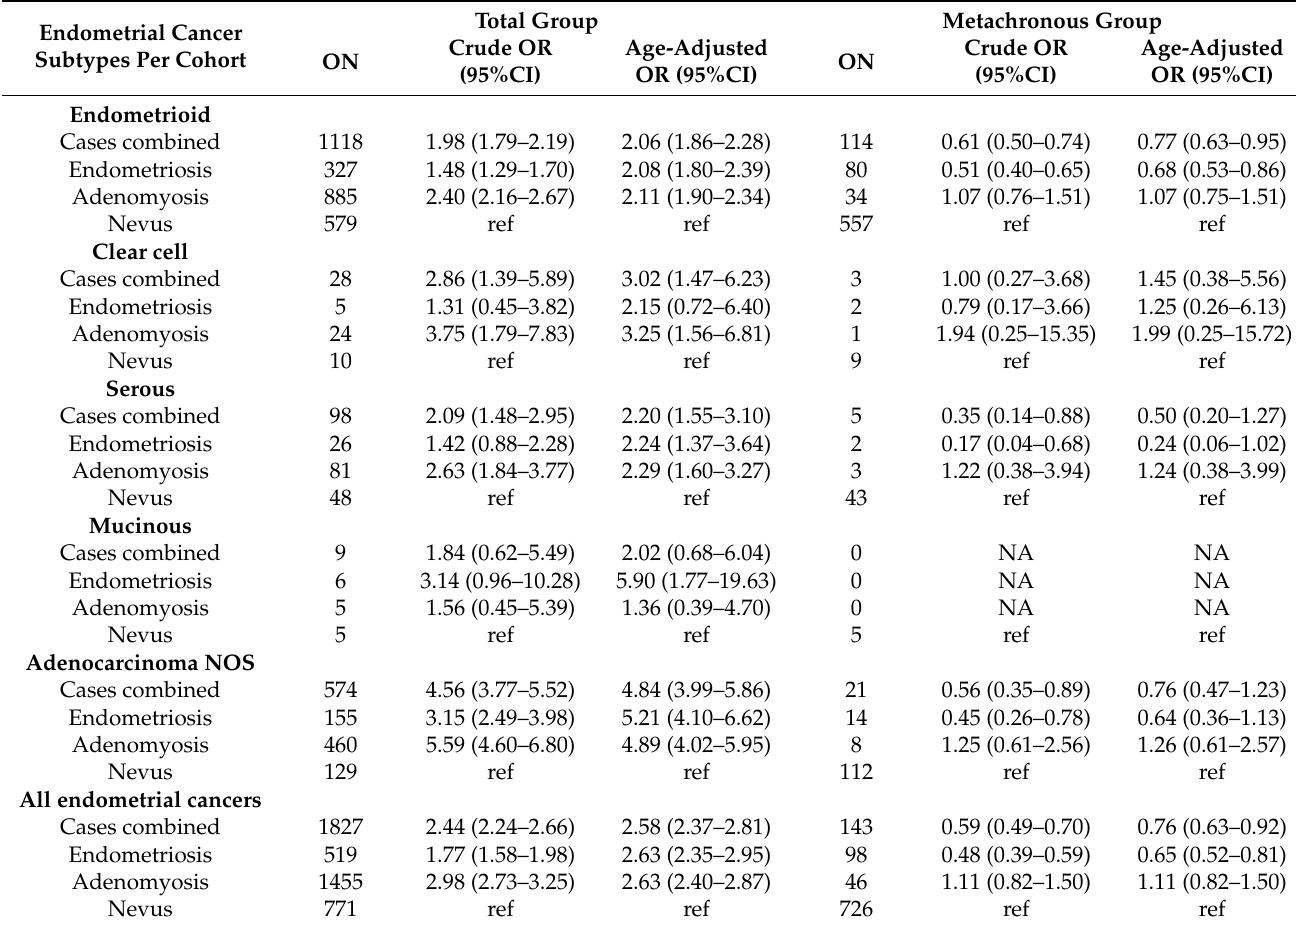
Table 3. Observed number of endometrial cancers, crude odds ratios, and age-adjusted odds ratios of endometrial cancers of women with endometriosis/adenomyosis combined, endometriosis solely, or adenomyosis solely compared with women with a benign dermal nevus, per endometrial cancer subtype and overall. Data are in numbers, percentages (%) or incidence rate ratios. Summed up numbers of endometriosis and adenomyosis are larger than the cases total because there were cases diagnosed with both endometriosis and adenomyosis. Metachronous group is defined as endometriosis, adenomyosis or nevus diagnosis at least a year before censoring date (autopsy, hysterectomy, or endometrial